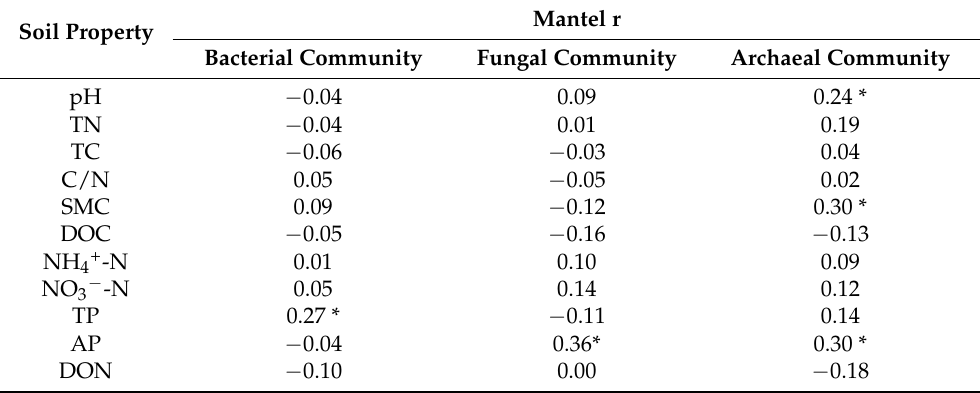
Table 2. Mantel tests (Spearman’s correlation) between microbial communities and soil nutrient properties. *: p <